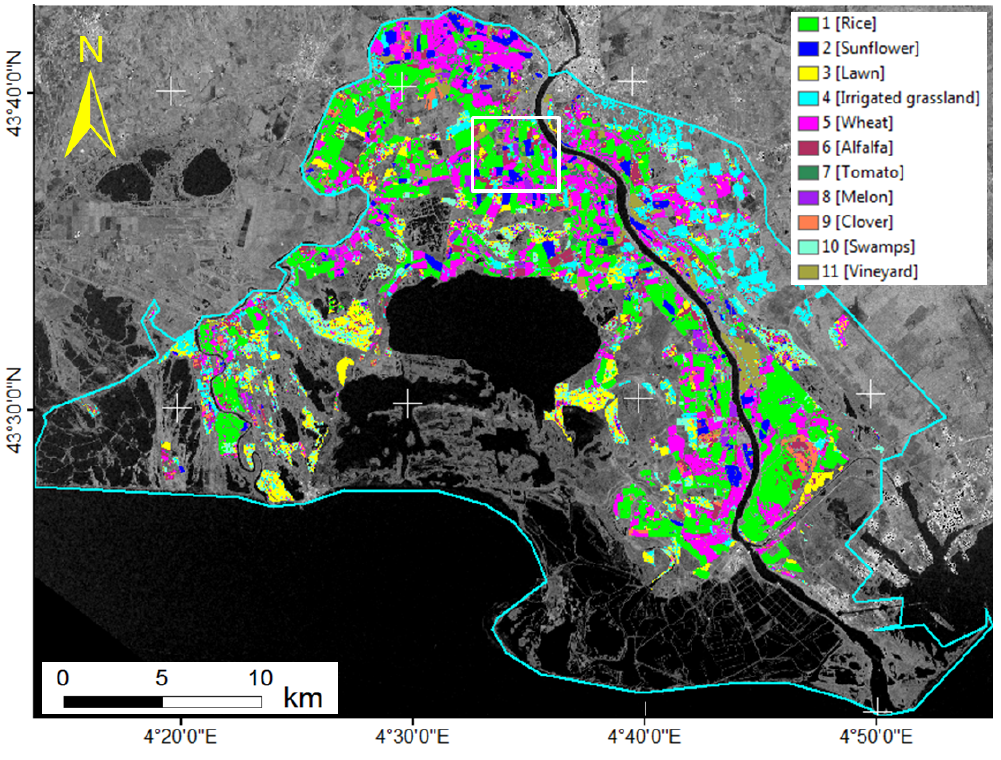
Figure 8. The agricultural land cover map in Camargue using the RNN-based GRU multitemporal SAR Sentinel-1.